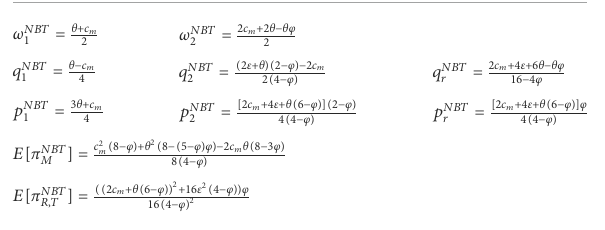
TABLE 5 The equilibrium outcomes of NBT scenario.